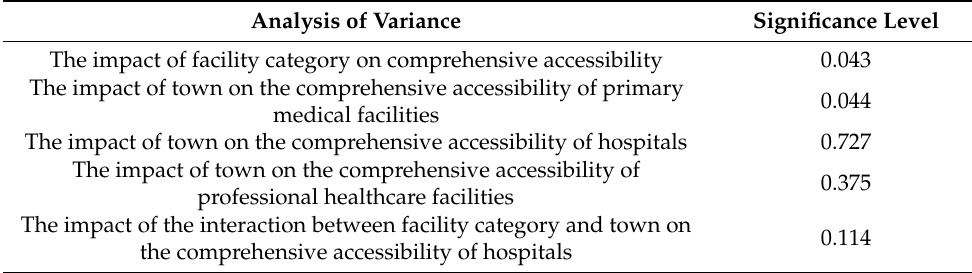
Table 15. Significance level of analysis of variance.